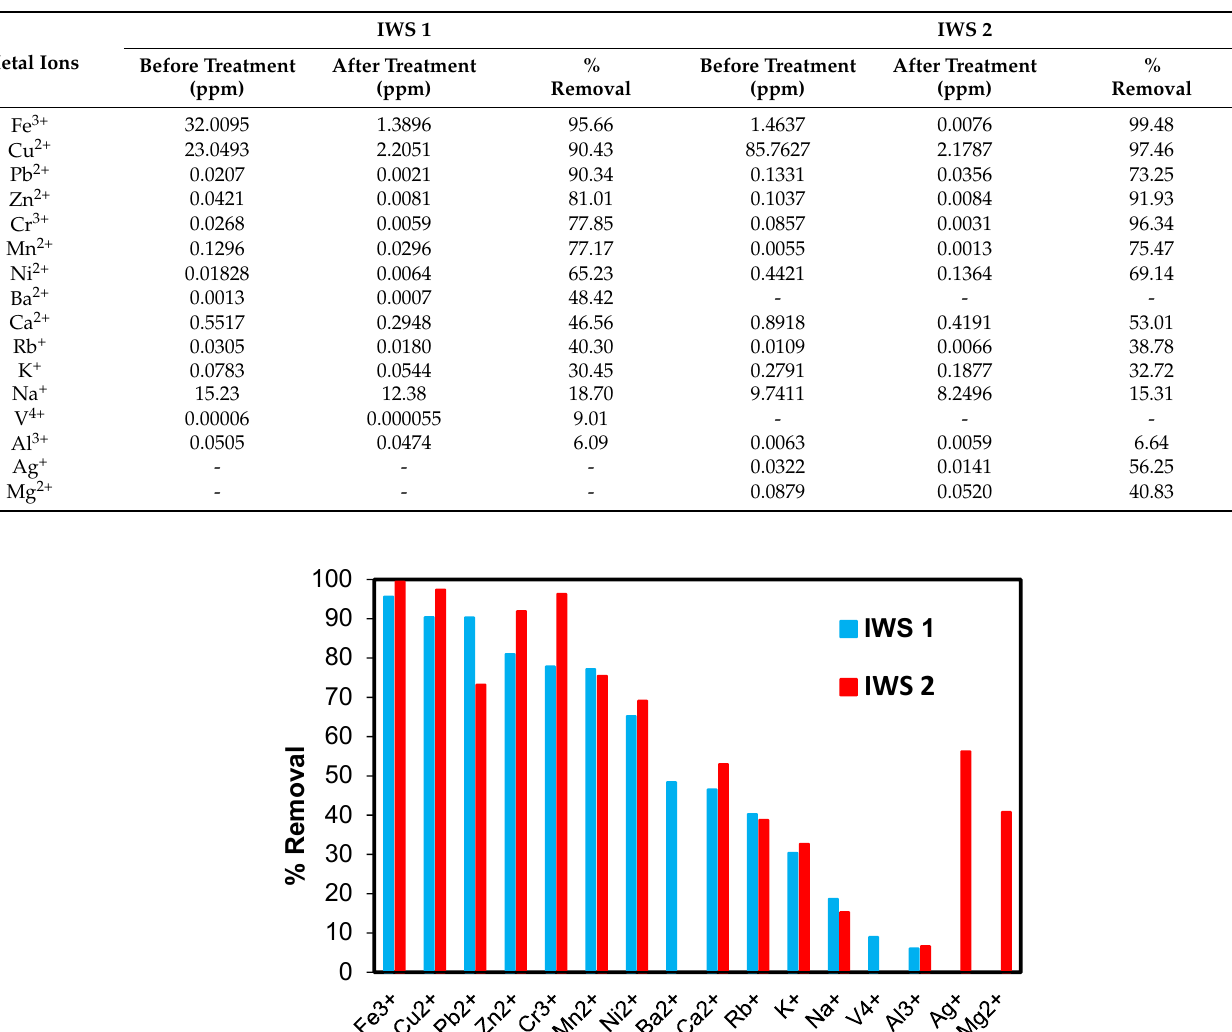
Table 6. Compositions of metal ions in two wastewater samples (IWS 1 and IWS 2) collected from electroplating factory in Singapore before and after treatment by the adsorbent.